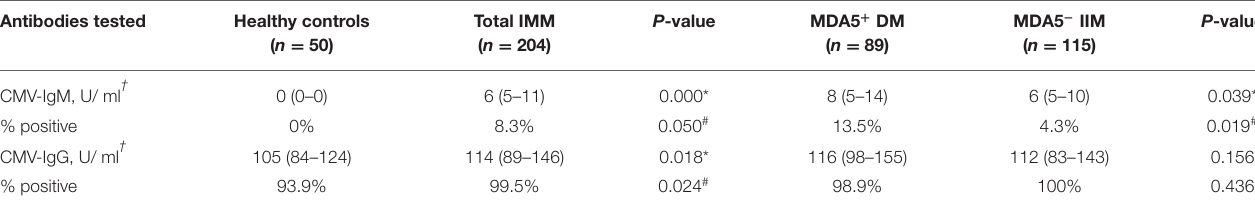
TABLE 2 | Distribution of CMV antibody profile in healthy individuals, IIM, MDA5 + DM, and MDA5 − IIM patients. Antibodies